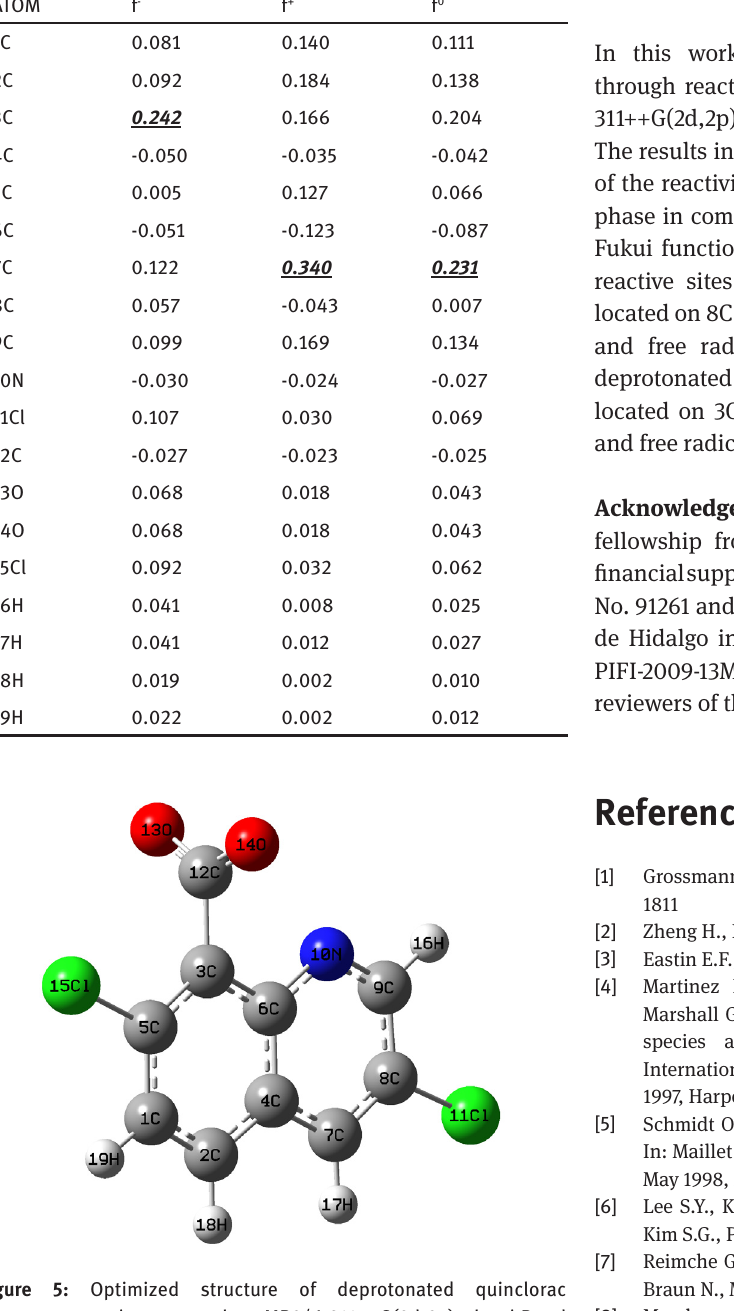
Figure 5: Optimized structure of deprotonated quinclorac in aqueous phase at the MP2/6-311++G(2d,2p) level.Bond distances are 1C-2C=1.37, 2C-4C=1.42, 4C-7C=1.41, 7C-8C=1.37, 8C-11Cl=1.76, 8C-9C=1.41, 9C-10N=1.31, 10N-6C=1.36, 6C-3C=1.43, 3C-5C=1.37, 12C-13O=1.25, 12C- 14O=1.25, 9C-16H=1.09, 7C-17H=1.08, 2C-18H=1.08, 1C-19H=1.08,